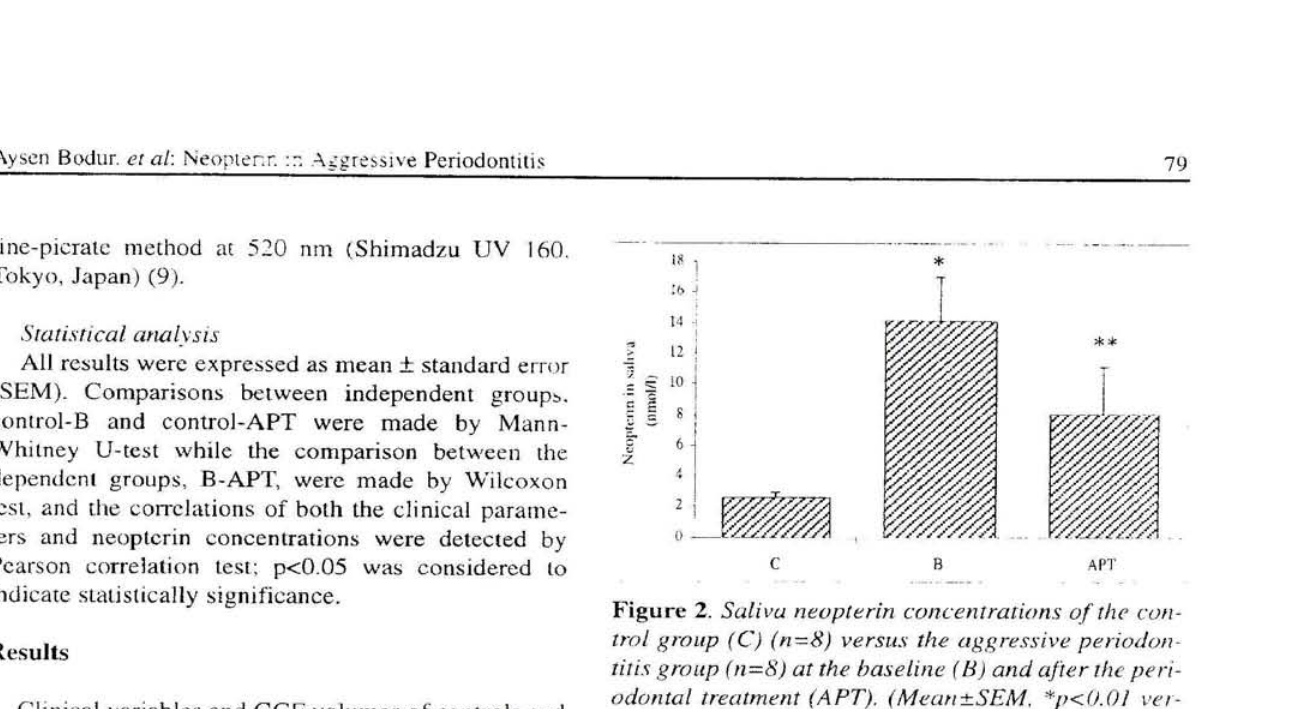
(pcO .Ol). After periodontal treatment salivary neopterin level was 8.02 ± 3 . 12 nmol/1, which was still